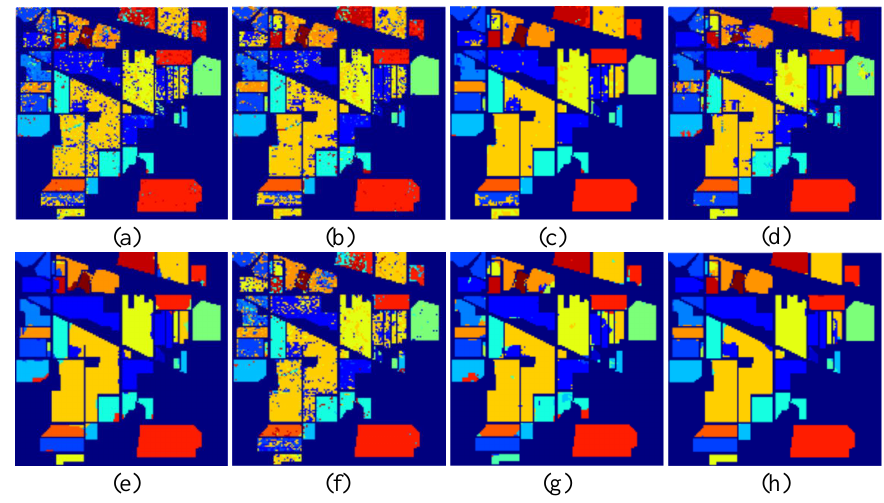
Figure 8. Classification maps using eight different methods on the Indian Pines dataset: ( a ) original; ( b ) RLDE; ( c ) MDA; ( d ) 2D-CNN; ( e ) 3D-CNN; ( f ) LSTM; ( g ) CNN+LSTM; ( h ) Bi-CLSTM.